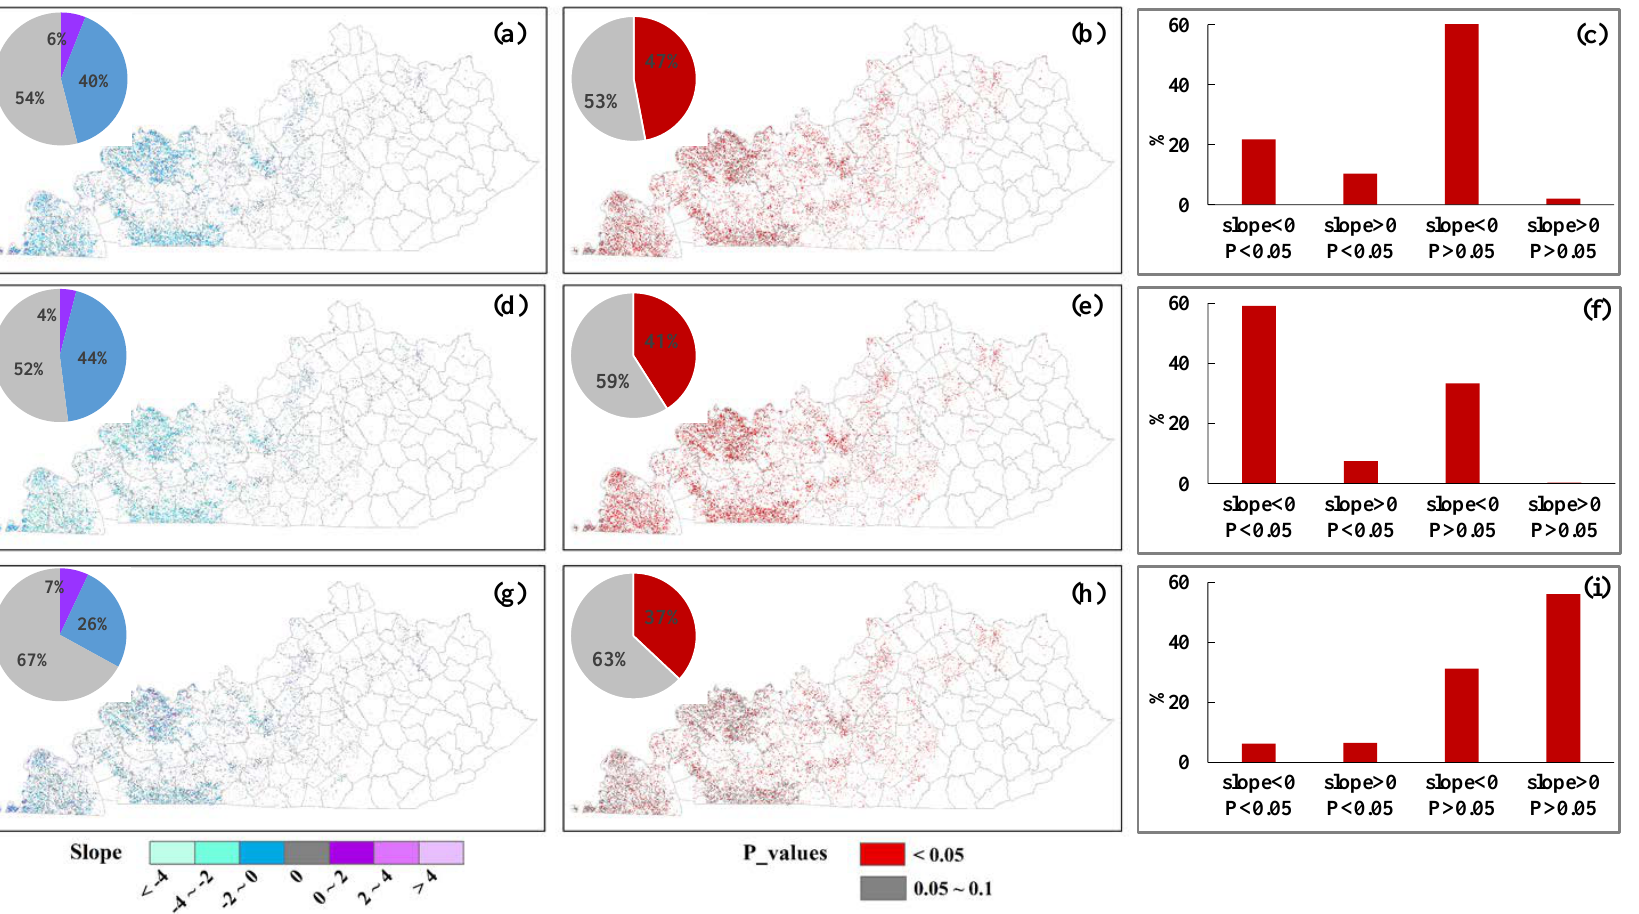
Figure 9. Slope, p values, and their percentages of planting dates ( a – c ) harvesting dates ( d – f ) and growing season length ( g – i ) of soybean in Kentucky, 2000–2018 (Slope: change rate of crop phenological dates; p values: the confidence of trend analysis; we only included pixels that were identified as soybean for more than 12 years in the Mann-Kendall statistical test).